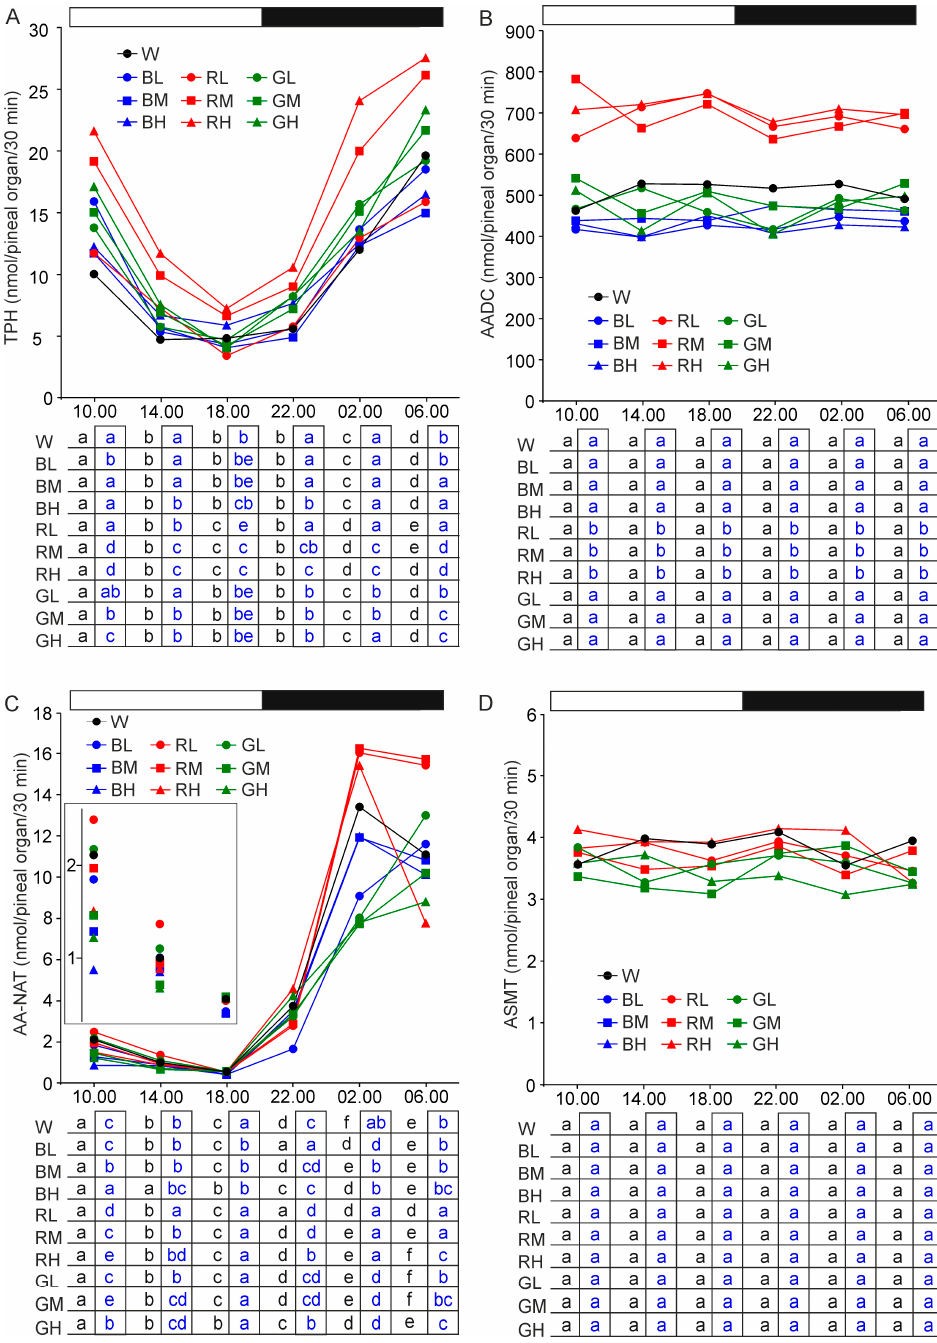
Figure 1. Activity (means) of tryptophan hydroxylase, TPH ( A ), aromatic amino acid decarboxylase, AADC ( B ), arylalkylamine N-acetyltransferase, AA-NAT ( C ) and N-acetylserotonin O-methyltransferase, ASMT ( D ) in the pineal organs of turkeys kept under white light (W) with intensity of 16 lx, blue light with intensities of 16 lx (BL), 32 lx (BM), and 64 1× (BH), red light with intensities of 16 lx (RL), 32 lx (RM), and 64 lx (RH), green light with intensities of 16 lx (GL), 32 lx (GM), and 64 lx (GH) during the photophase. Horizontal bar represents the periods of light and dark phases of a daily cycle. Insert shows data in a limited range of scale. The table charts below report results of the Duncan test. Black letters show differences between time-points within a group (horizontal line) and blue letters - between groups at each time-point (vertical line). The same letters indicate means, which are not significantly